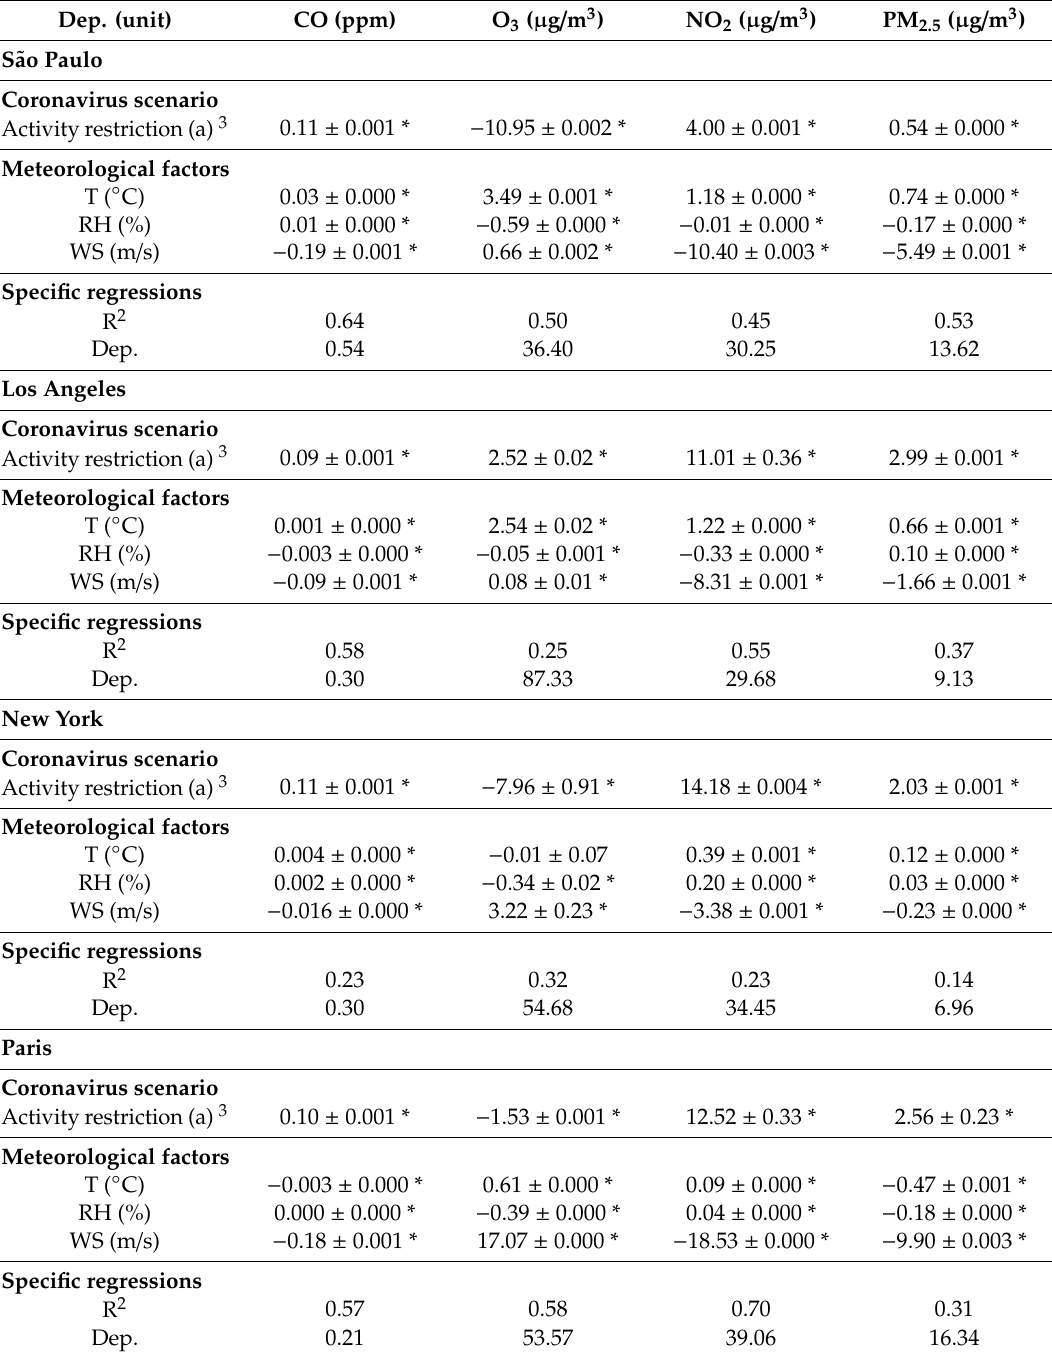
Table 3. E ff ects of activity restrictions and meteorology on air quality; predicting air quality during the month of March (2015–2020); measurements from S ã o Paulo, Los Angeles, New York and Paris networks 1,2